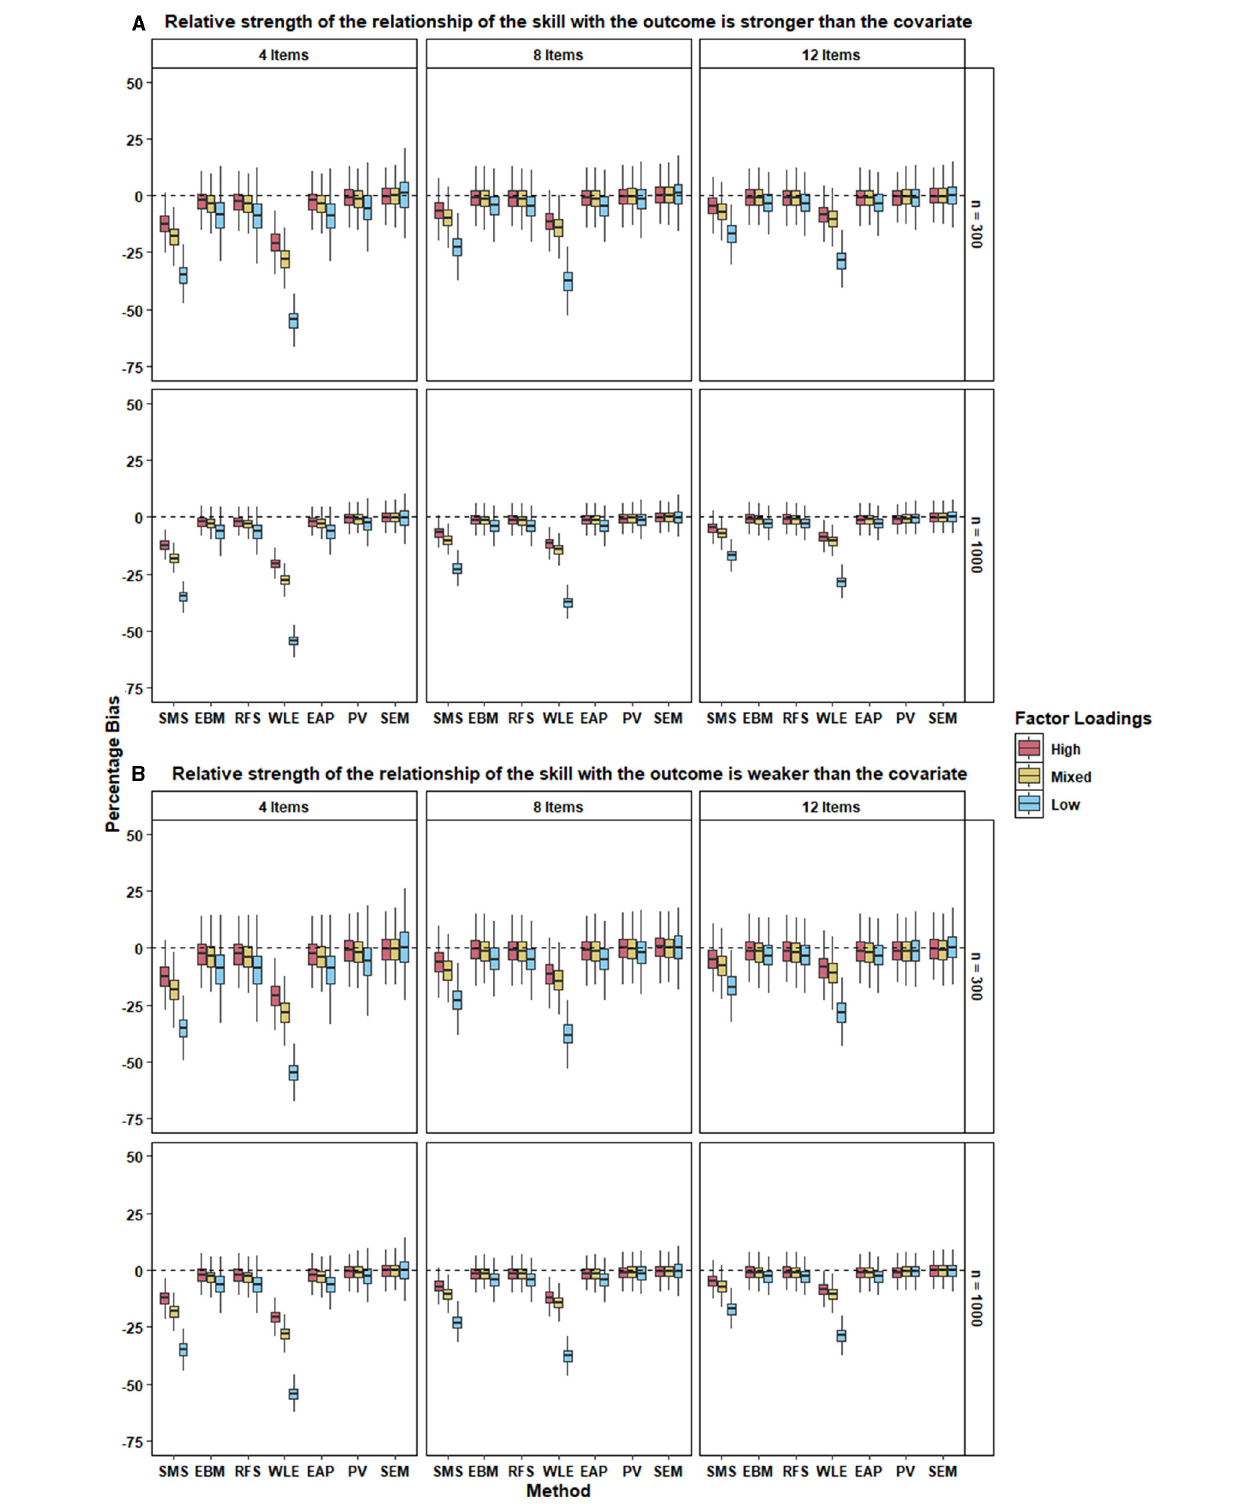
FIGURE 3 | The two panels, (A,B) , present the boxplot of percentage bias in the regression coefficient of the skill for the different approaches under each condition when the relative strength of the relationship between the skill with the outcome is stronger and weaker respectively, than the covariate. 500 replications of each condition were used to create the